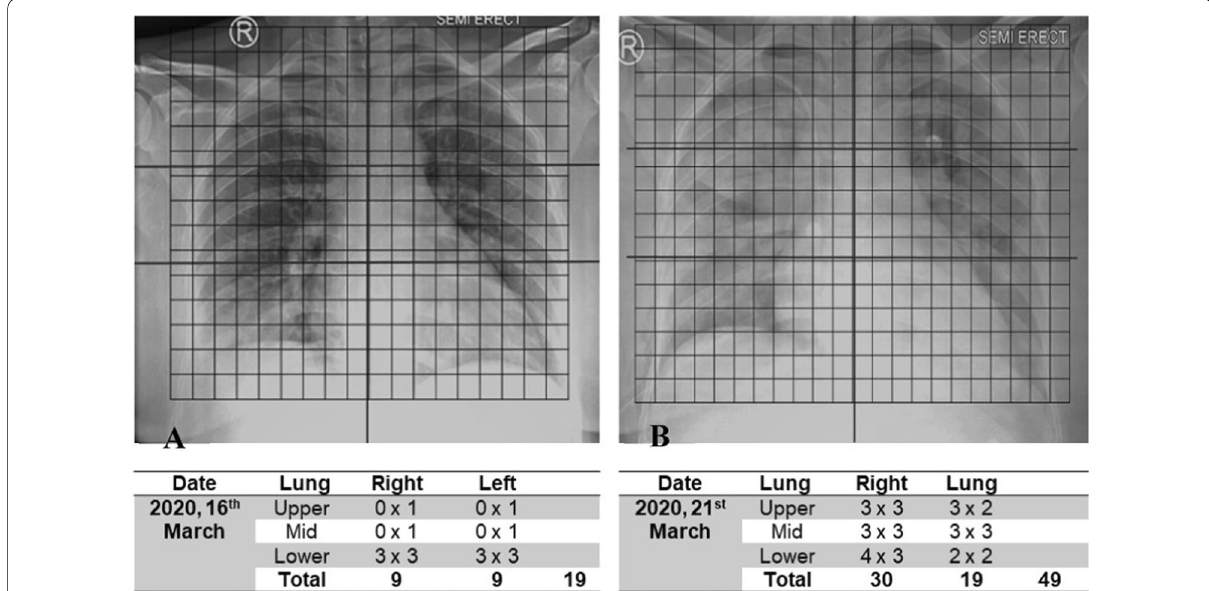
Fig. 2 Radiologic severity index assessment in COVID-19 pneumonia patient. This image shows serial chest X-ray RSI values in same patient with COVID-19 pneumonia. A RSI values on initial chest X-rays at 16 March 2020 and B RSI values on serial chest x-rays at 21 March 2020. There is an increase in RSI value at 5-day